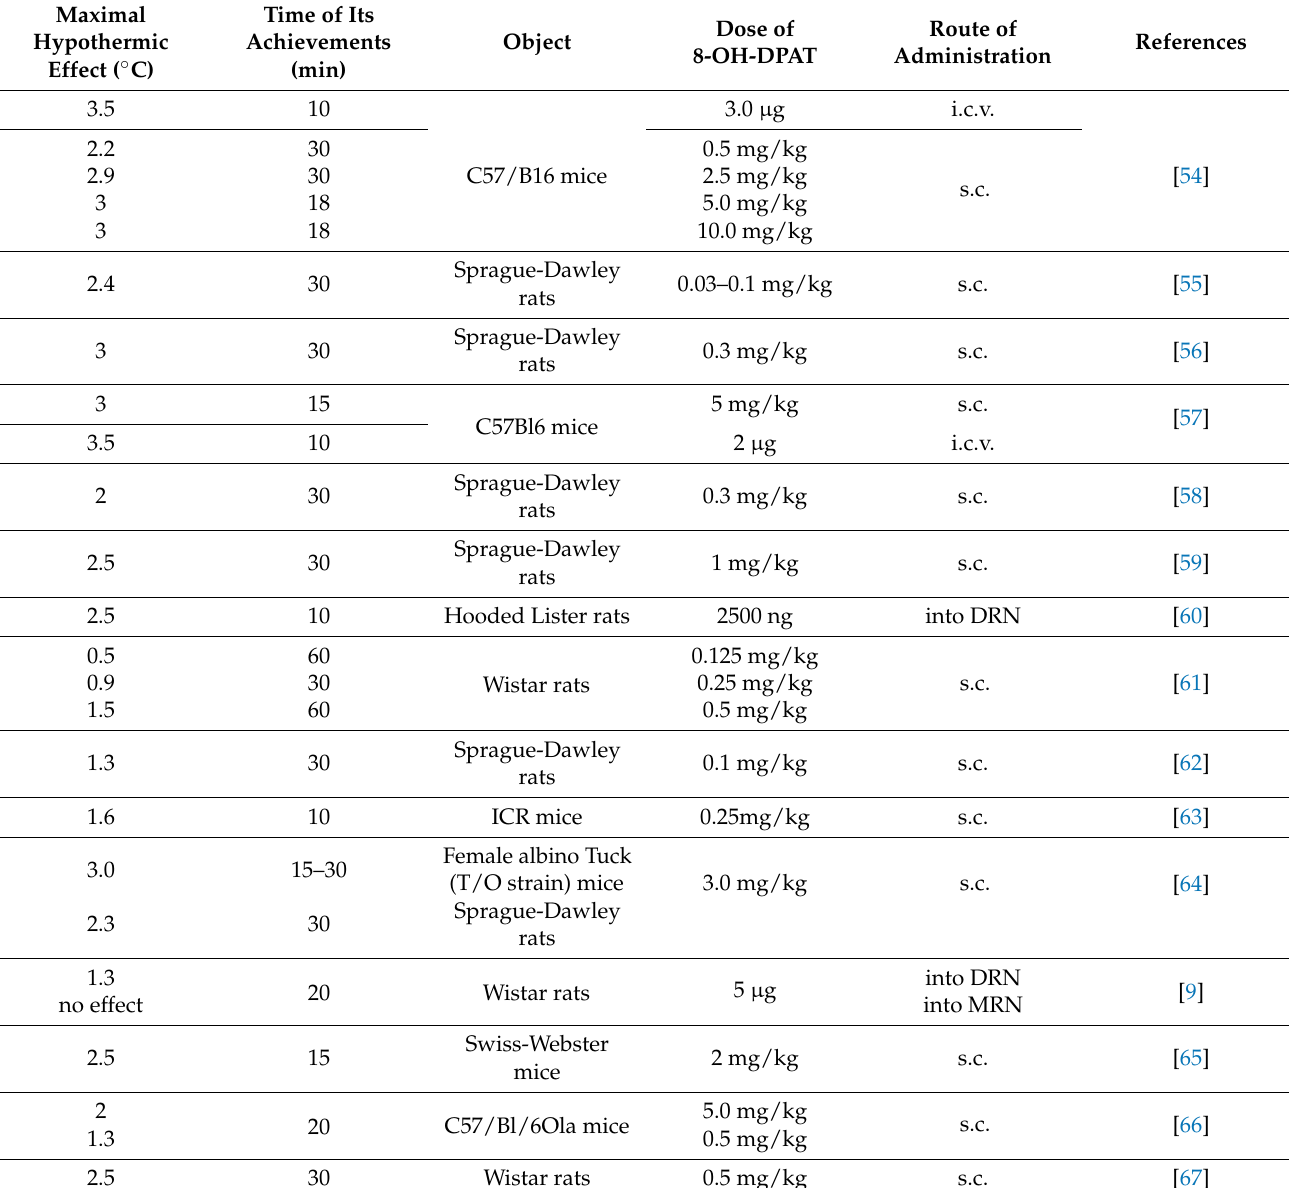
Table 1. Maximal hypothermic effect of selective 5-HT 1A receptor agonist 8-OH-DPAT in warm-blooded animals.